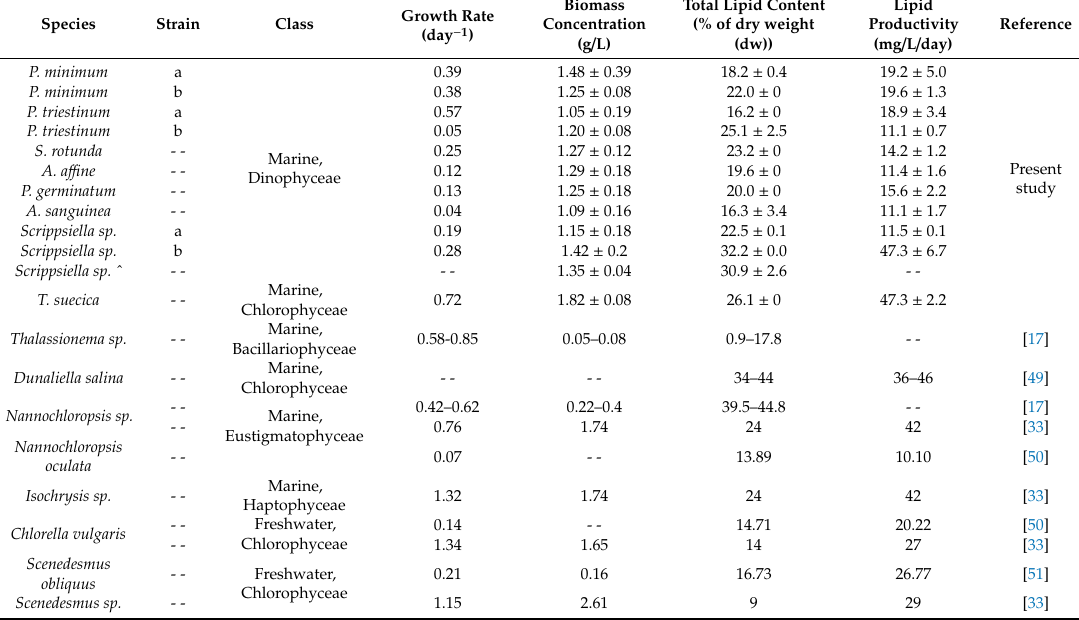
Table 3. Growth rate, biomass, lipid content, and lipid productivity of the selected algal strains in the present study compared to reported values of freshwater and marine species. Data expressed as mean ± SD (n = 3) for the present study; mean values were adopted from